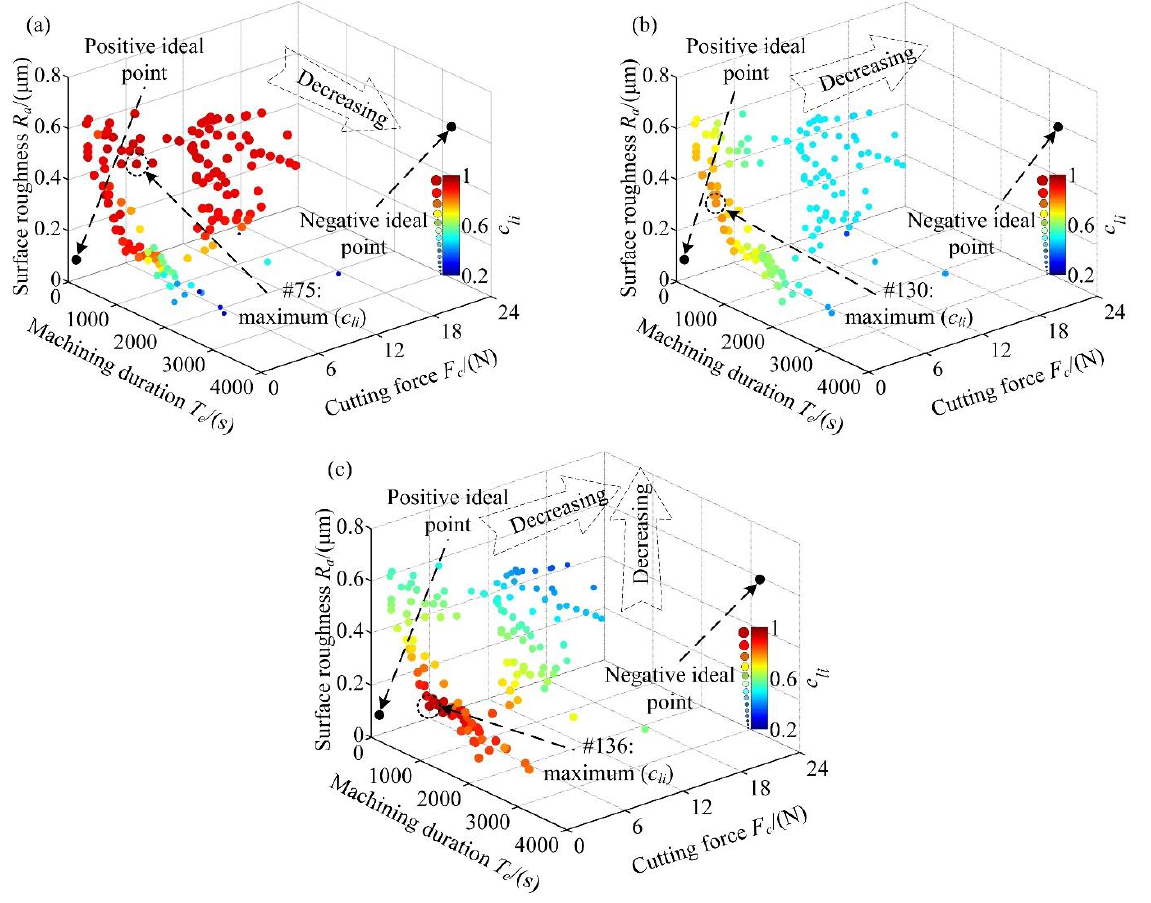
Figure 8. Sorted Pareto solutions of the three customized machining schemes: ( a ) P 1 , ( b ) P 2 , ( c ) P 3.